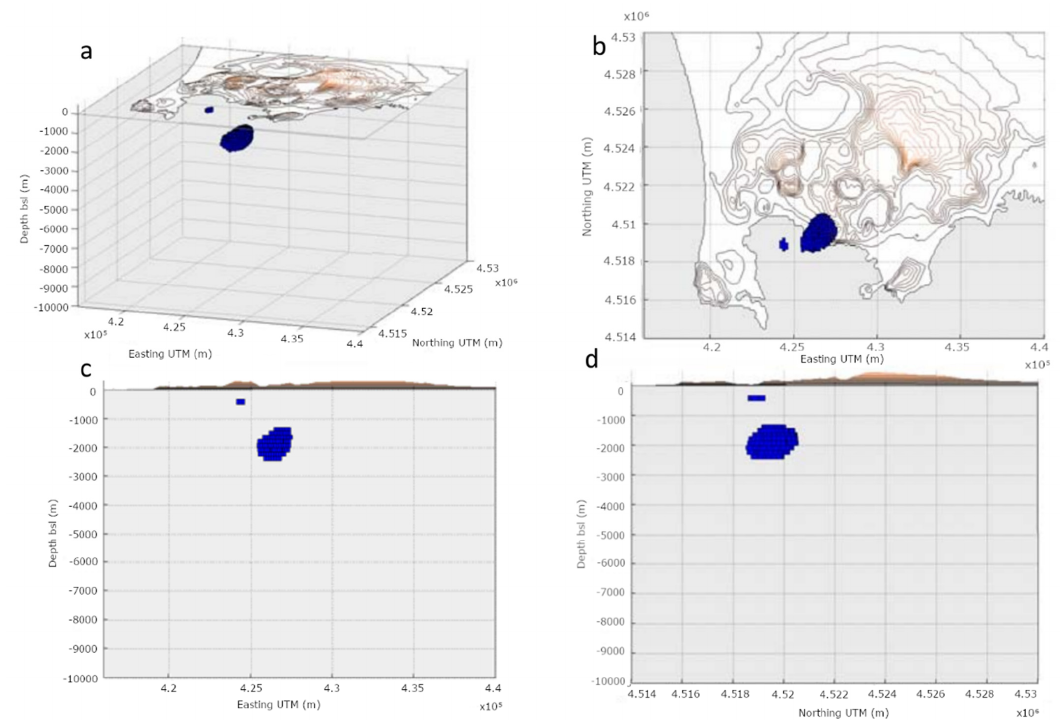
Figure 10. Source location, depth and shape for deflation period of 2000–2005. ( a ) 3D perspective; ( b ) map view of source below Campi Flegrei caldera; ( c ) EW vertical profile; ( d ) NS vertical profile